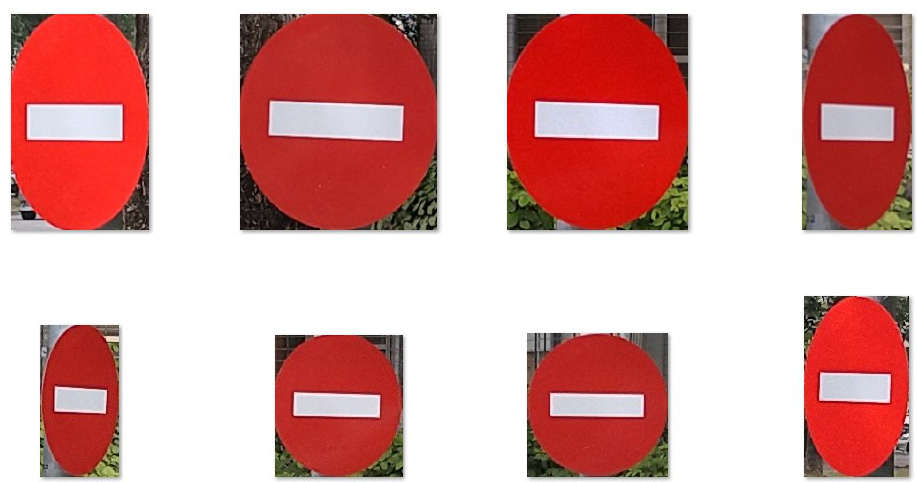
Figure 7. “No entry” traffic sign image cropped for use in Xception.